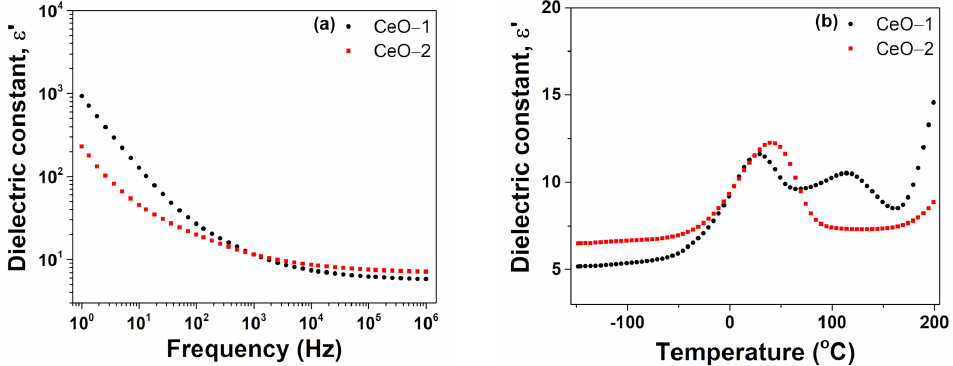
Figure 7. Dielectric constant dependence of cerium oxide nanoparticles ( a ) on the frequency at room temperature, ( b ) on temperature at 1